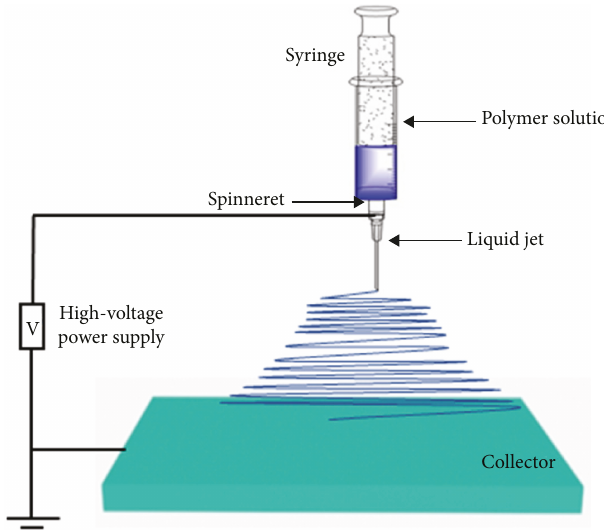
Figure 1: The typical examples of micropore fabrication techniques electrospinning.